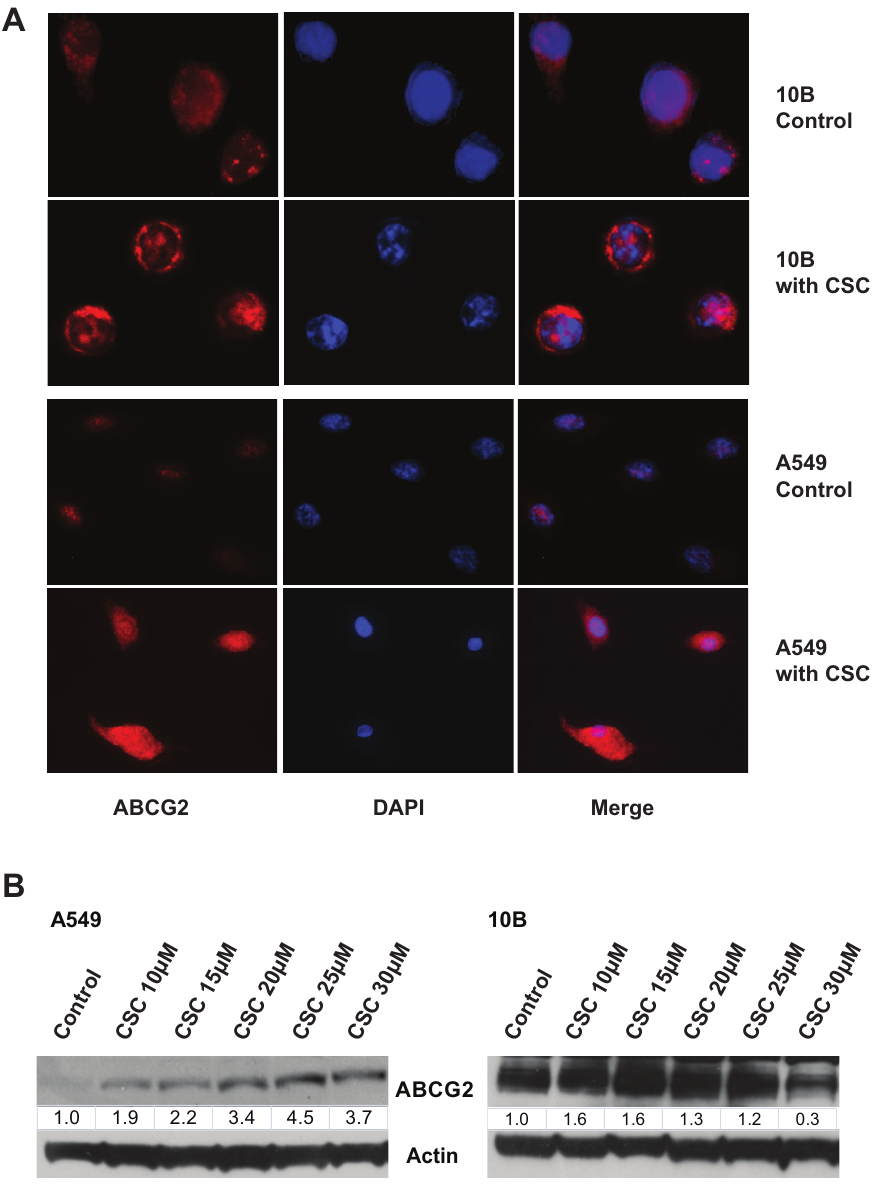
Figure 2. CSC treatment induces the expression and membrane localization of ABCG2. ( A ) Immunofluorescence microscopy identifies the cellular localization of ABCG2 with and without CSC. Results indicate that CSC exposure induces translocation of ABCG2 to the plasma membrane in 10B and A549. ( B ) Western blot analysis shows dose dependent increase in ABCG2 expression in response to CSC treatment.